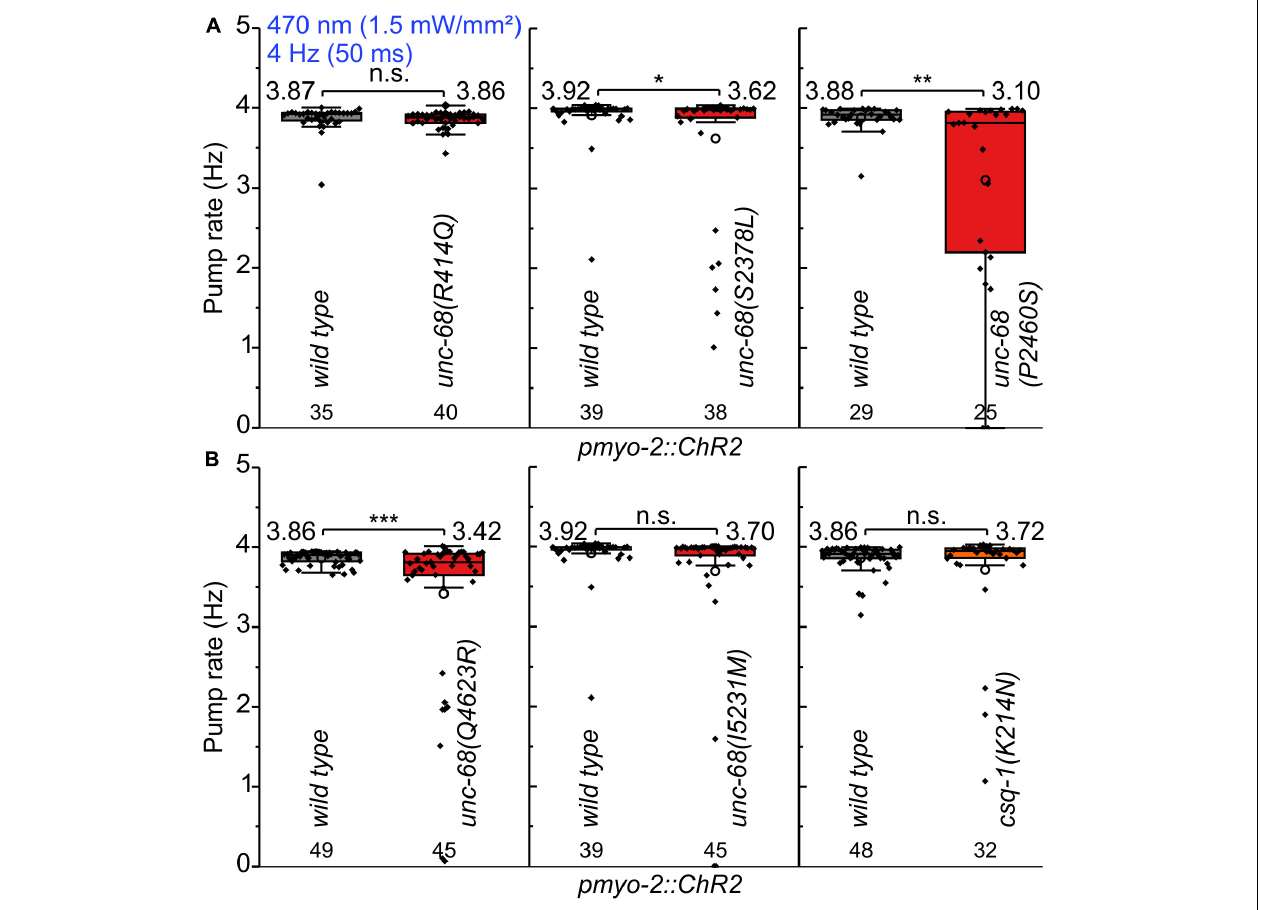
FIGURE 2 | Pumping ability of CPVT mutation bearing strains upon 4 Hz stimulation. (A,B) In ScreenChip TM recordings, S2378L, P2460S, and Q4623R show a reduced pump rate compared to wild type in pmyo-2::ChR2 background. Box plot (25%, 75%; whisker: 1.5 IQR) includes every data point (rhomb), mean (circle), and median (line). Mean values, N-numbers, and significance levels (asterisks) are next to the corresponding box. Two-sample t -test: n.s., not significant, * P ≤ 0.05, ** P ≤ 0.01, and *** P ≤